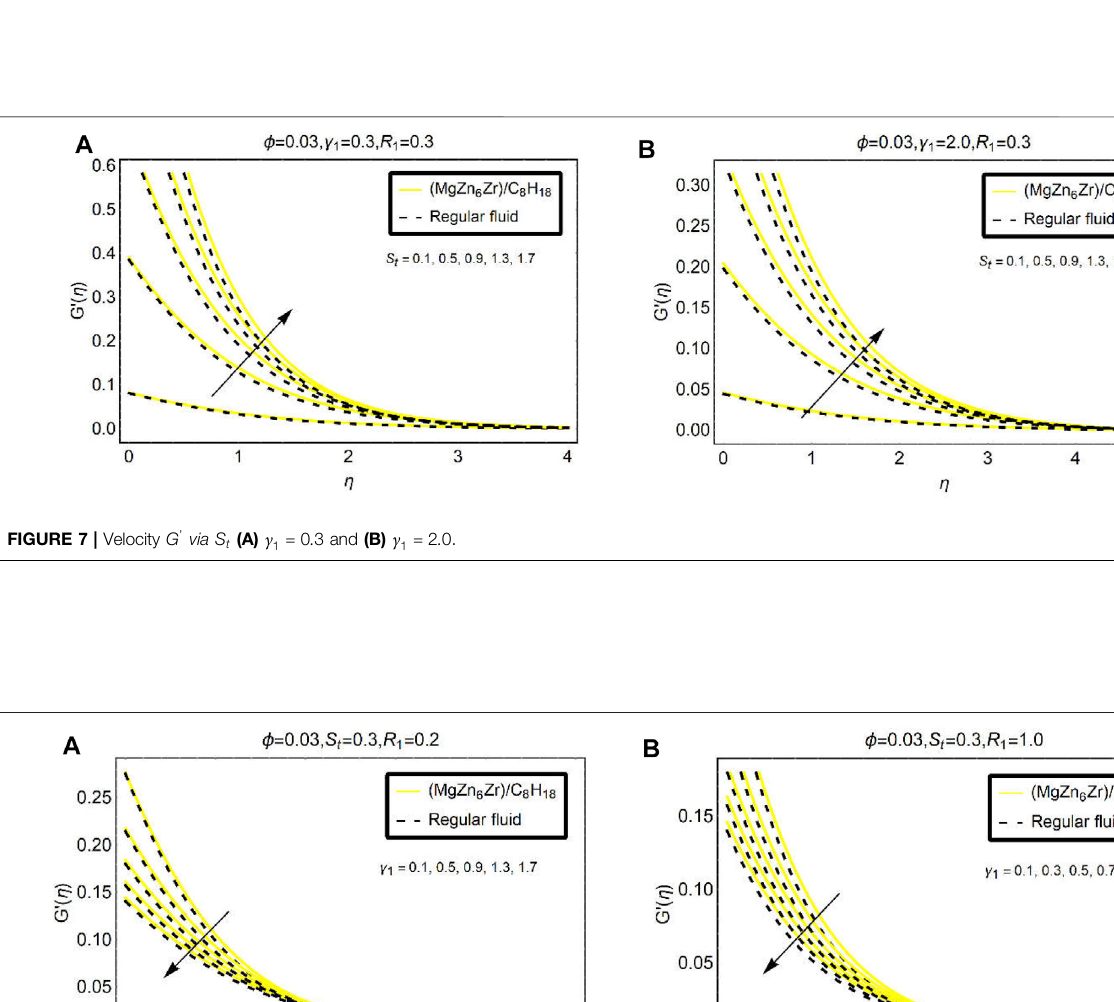
Frontiers in Energy Research |